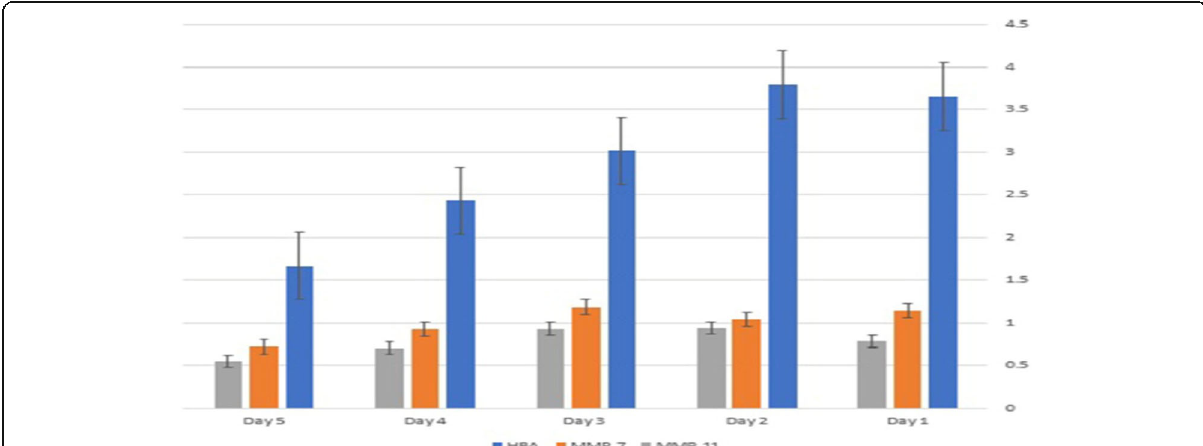
Fig. 2 Mean levels of HBA, MMP7 and MMP11 through different days of menstruation with higher levels of HBA, MMP7 than MMP11 throughout the